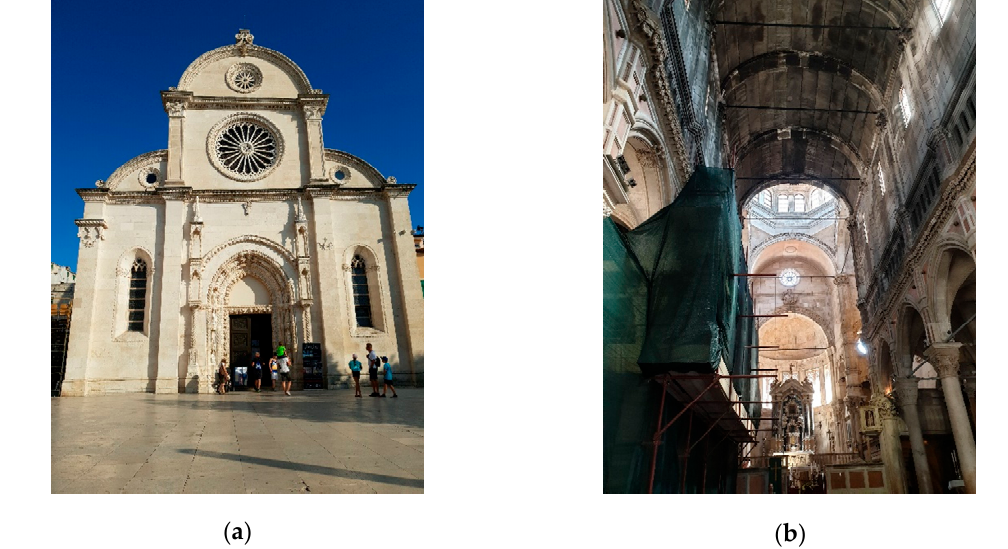
Figure 6. Cathedral of St. James in Šibenik, Croatia. ( a ) West view of cathedral and ( b ) iron tie rods inside the cathedral.